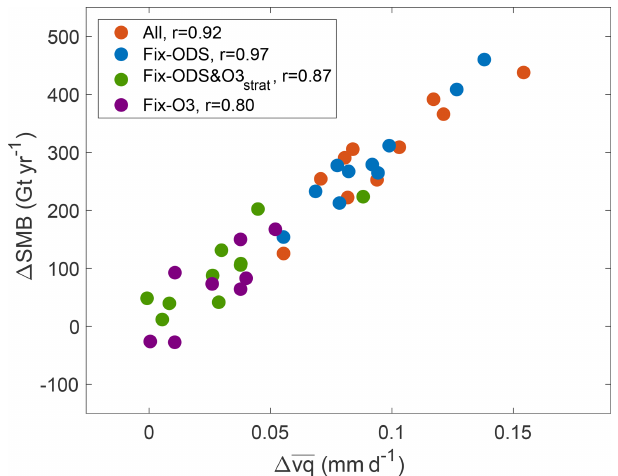
Figure 4. The response over the second half of the 20th century forcing of the DJF SMB ( (cid:49) SMB) as a function of the merid- ional moisture flux convergence ( (cid:49)vq ) in the full forcing ensem- ble (All, red), fixed ODS ensemble (Fix-ODS, blue), fixed ODS and stratospheric ozone ensemble (Fix-ODS&O3 strat , green), and fixed stratospheric and tropospheric ozone ensemble (Fix-O3, pur- ple). Correlations appear in the upper left